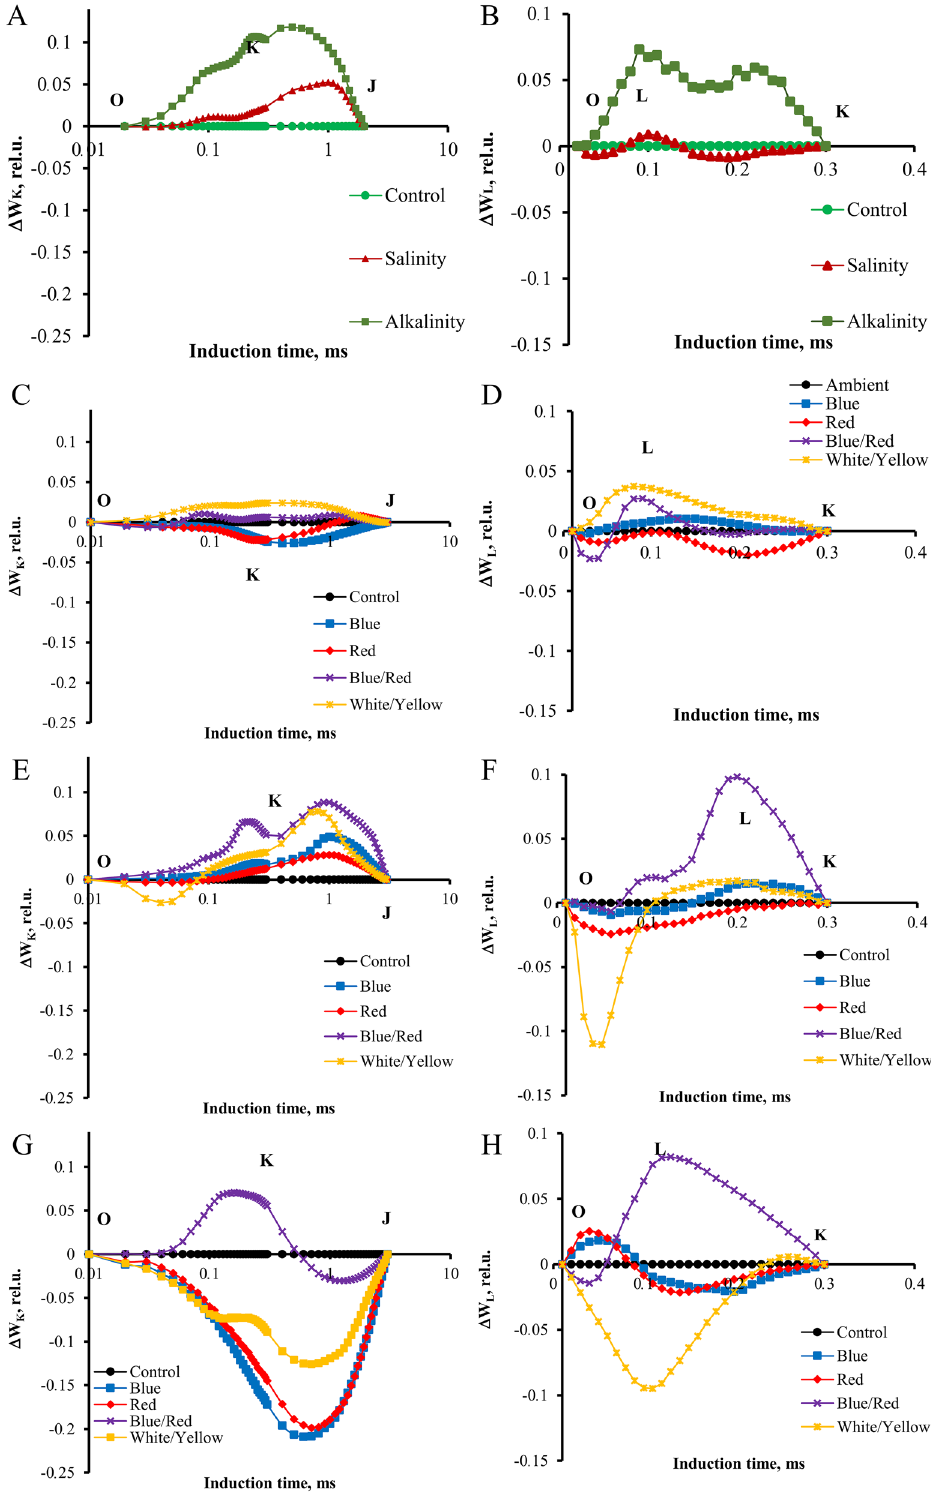
Figure 4. Differential curves of ΔW K and ΔW L of chlorophyll a fluorescence of strawberry cv. Paros. ( A,B ) In ambient light (control, salt stress, alkalinity stress); ( C,D ) non-stressed in different light spectra (ambient, blue, red, blue/red, white/yellow); ( E,F ) under salt stress in different light spectra (ambient, blue, red, blue/red, white/ yellow); ( G,H ) under alkalinity stress in different light spectra (ambient, blue, red, blue/red, white/yellow). Biophysical parameters were determined with "PEA Plus" software version 1.12 (http:// www. hansa tech- instr uments. com). The graphs were drawn using Microsoft Excel version 2016 (https:// www. micro soft.